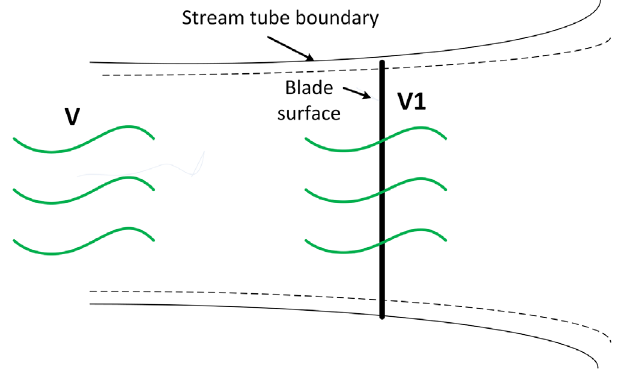
Figure 5. Wind of velocity V coming from far and passing through blade with velocity V 1 .